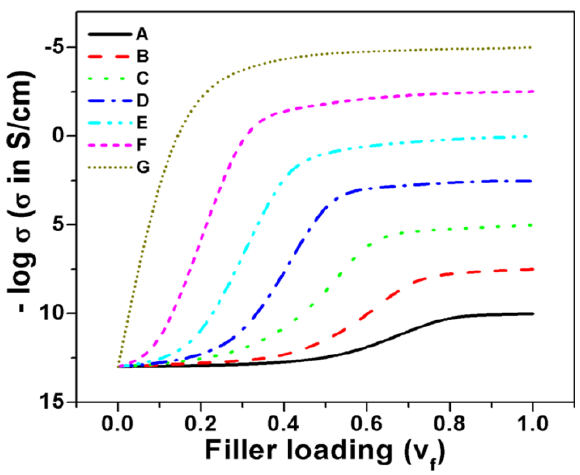
Figure 1. Variation of conductivity against filler loading (volume fraction) for polymer composite systems, (A–F) S-shaped curve, (G) non S-shaped curve.